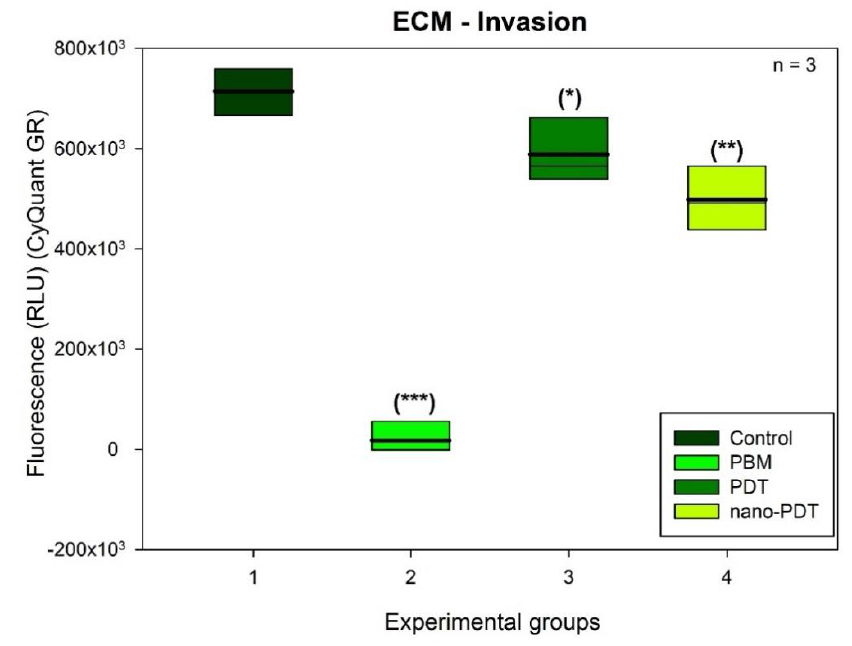
Figure 7. ECM cell invasion assay of lung epithelial carcinoma cells (A549) 24 h post-PDT treatment. Table 2. ECM data of A549 lung cancer cells 24 h post-PDT treatment. The standard (Std) was ob- tained using the initial cell seeding concentration of 5 × 10 4 that represents 100% cell invasion. The concentration of cells that passed through the ECM were calculated, as was the percentage of cells that passed through the ECM compared to the Std.